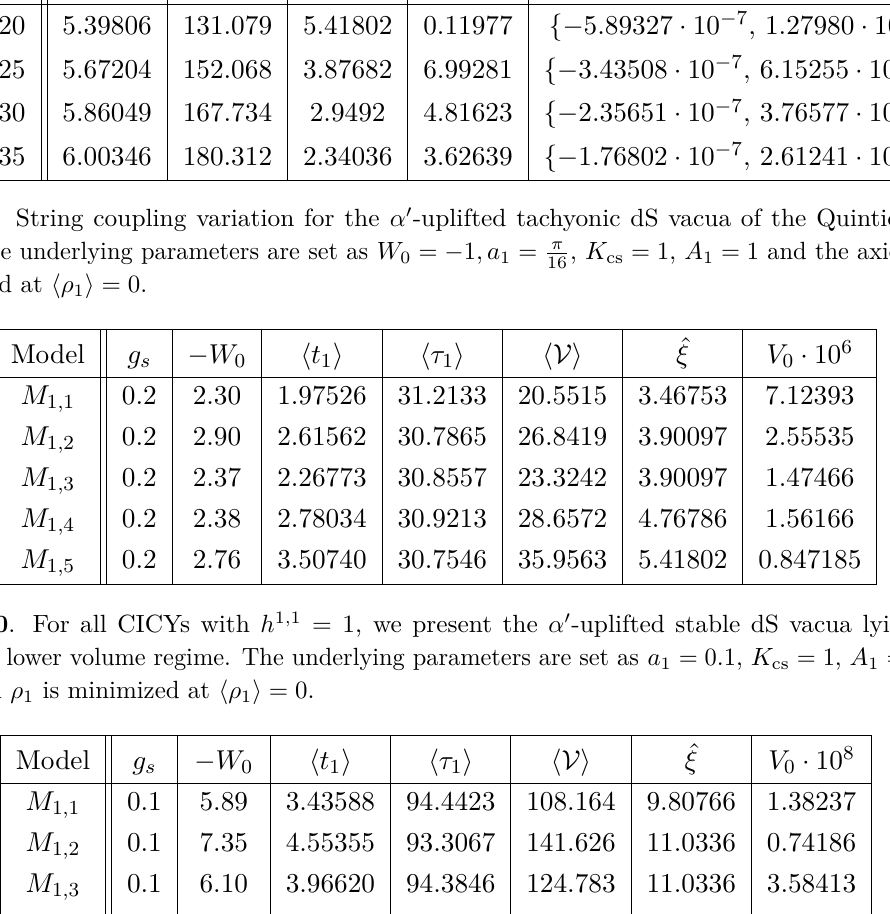
= π , K = 1 , A = 1 1 cs 1 100